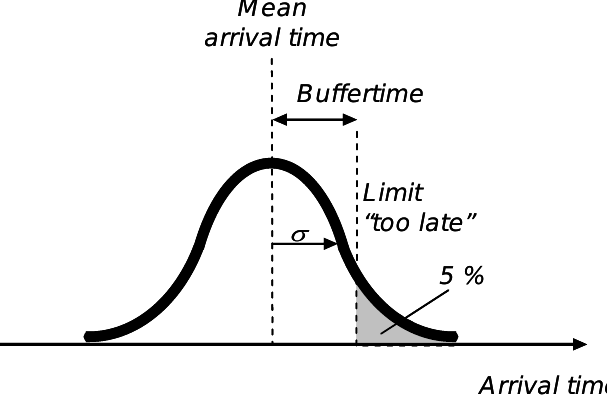
Figure 3. Mean arrival time and